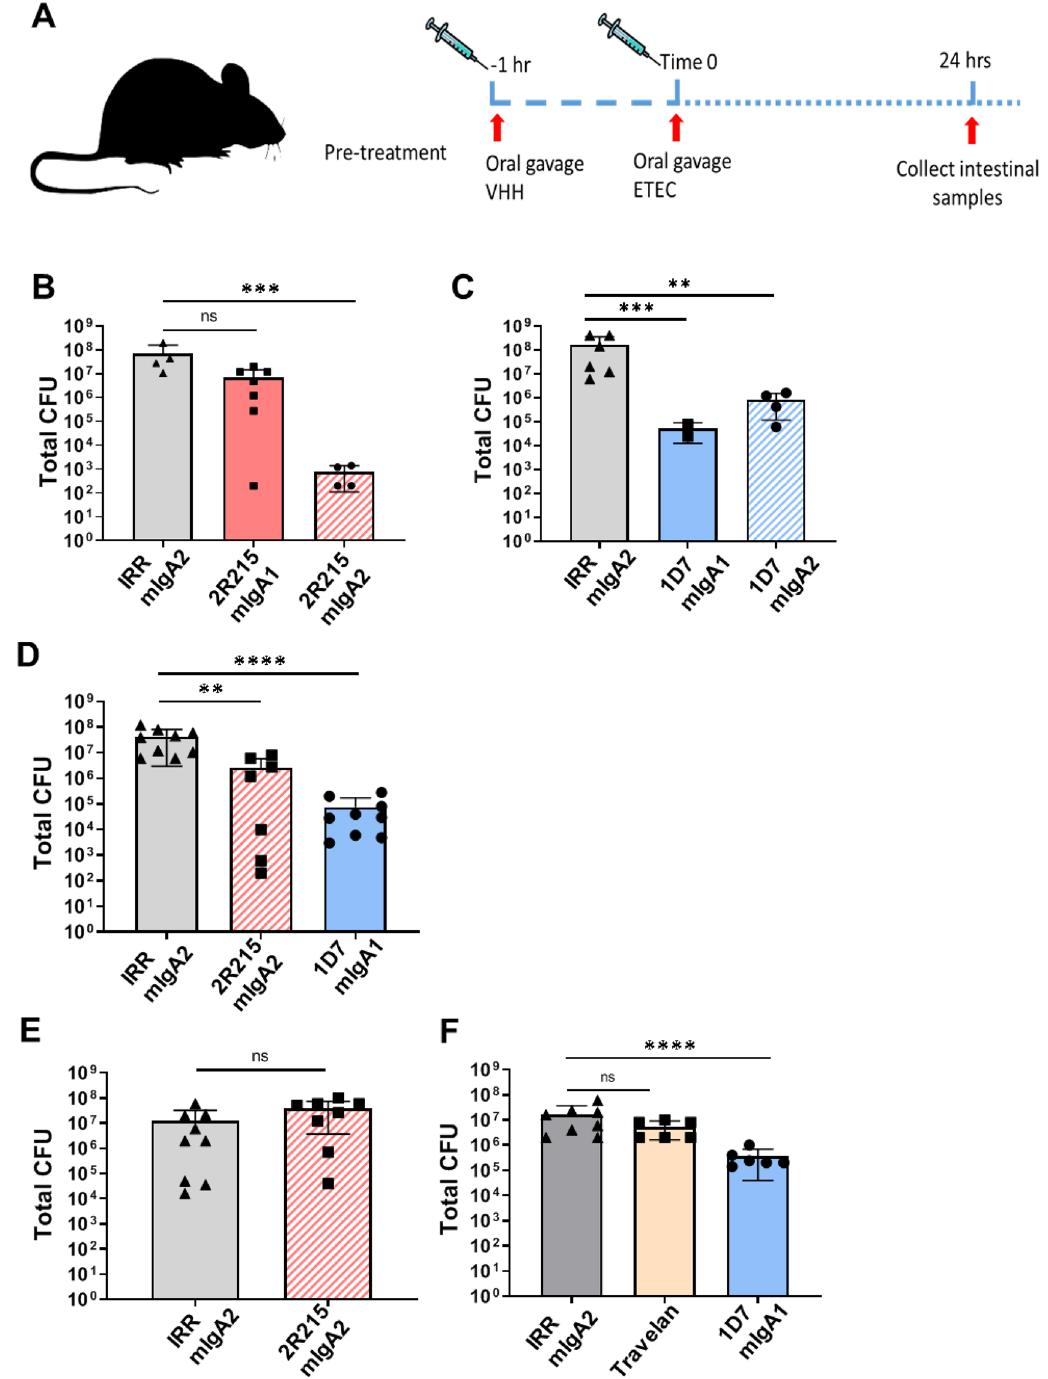
Figure 6. IgA Fc fusion enhances in vivo potency of 2R215 and 1D7. ( A ) Cartoon representation of pre- treatment protocol of VHH administration. VHH are administered one or two hours prior to administration of 10 7 CFU of H10407. Animals are euthanized 24 h after challenge, and bacterial colonies in the small intestine are counted. ( B , C ) DBA/2 mice were challenged intragastrically with 10 7 CFU of H10407 pre-incubated with 10 mg/kg of fusionbody. Treatment with 1D7 VHH-IgA1 resulted in 3.5 log reduction in CFU, P < 0.001) and 2R215 VHH-IgA2 in 5 log reduction in CFU ( P < 0.001). ( D ) Fusionbodies 2R215 and 1D7 were intragastrically administered one hour prior to administration of 10 7 CFU of H10407. Fusionbody pre-treatment resulted in reduction of CFUs by 1.2 log for 2R215 VHH-IgA2 ( P < 0.01) and 2.7 log for 1D7 VHH-IgA1 ( P < 0.0001). Two biological replicates were performed. ( E , F ) Fusionbodies 2R215 and 1D7 and Travelan were intragastrically administered two hours prior to administration of 10 7 CFU of H10407. A 1.7 log reduction in total CFUs was observed in 1D7 VHH-IgA1 treated animals as compared to the group treated with irrelevant control ( P < 0.0001). Two biological replicates were